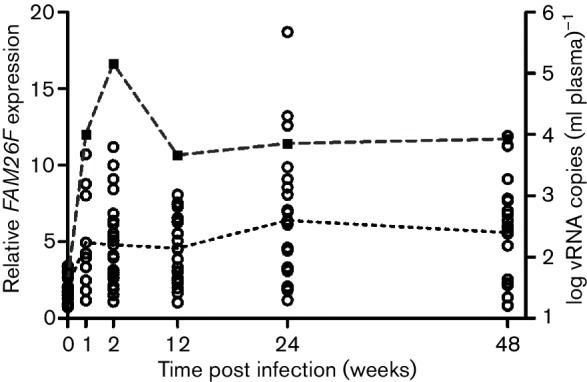
FAM26F gene expression after SIV-infection in relation to viral load. (a) Relative FAM26F transcript levels were determined at specified time points, before and after SIV-infection of rhesus macaques. Each time point shows data from 9 to 24 macaques. Expression of FAM26F (open circles) was significantly upregulated after SIV-infection as compared with its pre-infection values until the end of the study period (P<0.0008, Mann Whitney test). Log10 of the geometric mean of plasma viral RNA (vRNA) copies is shown as a dashed line and filled squares. Mean of relative FAM26F gene expression is depicted as a dotted line.